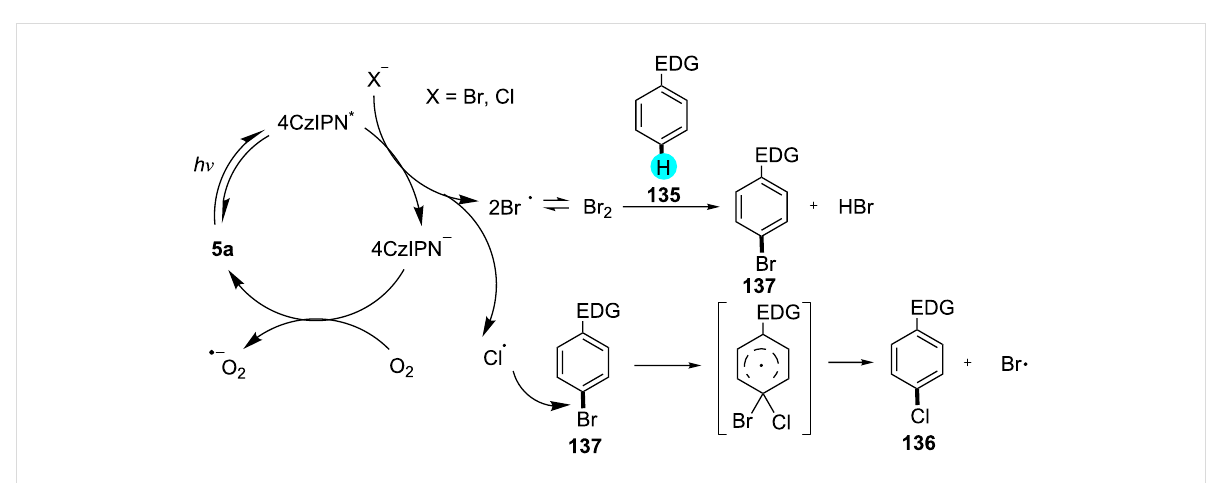
Figure 23: Plausible mechanism for the oxidative photocatalytic monochlorination using 5a